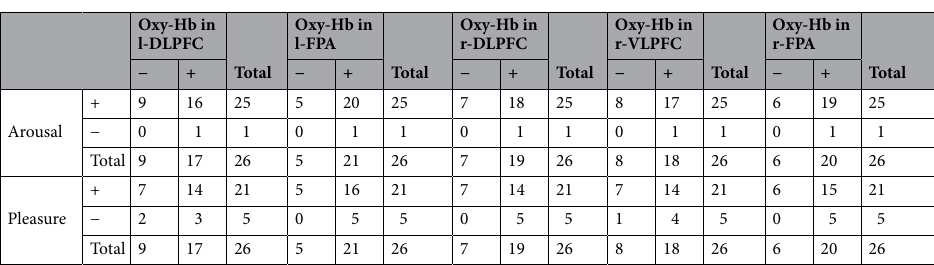
Table 1. Coincidence frequency between running-induced mood change and sub-regional prefrontal activation for McNemar test. Presented values are number of participants. The contrasts between [(post- session)−(pre-session)] in RUN and [(post-session)−(pre-session)] in CON for each variable was subjected to analysis. Significant coincidences among variables were observed. l-DLPFC = left dorsolateral prefrontal cortex, l-FPA = left frontopolar area, r-DLPFC = right dorsolateral prefrontal cortex, r-VLPFC = right ventrolateral prefrontal cortex, r-FPA = right frontopolar